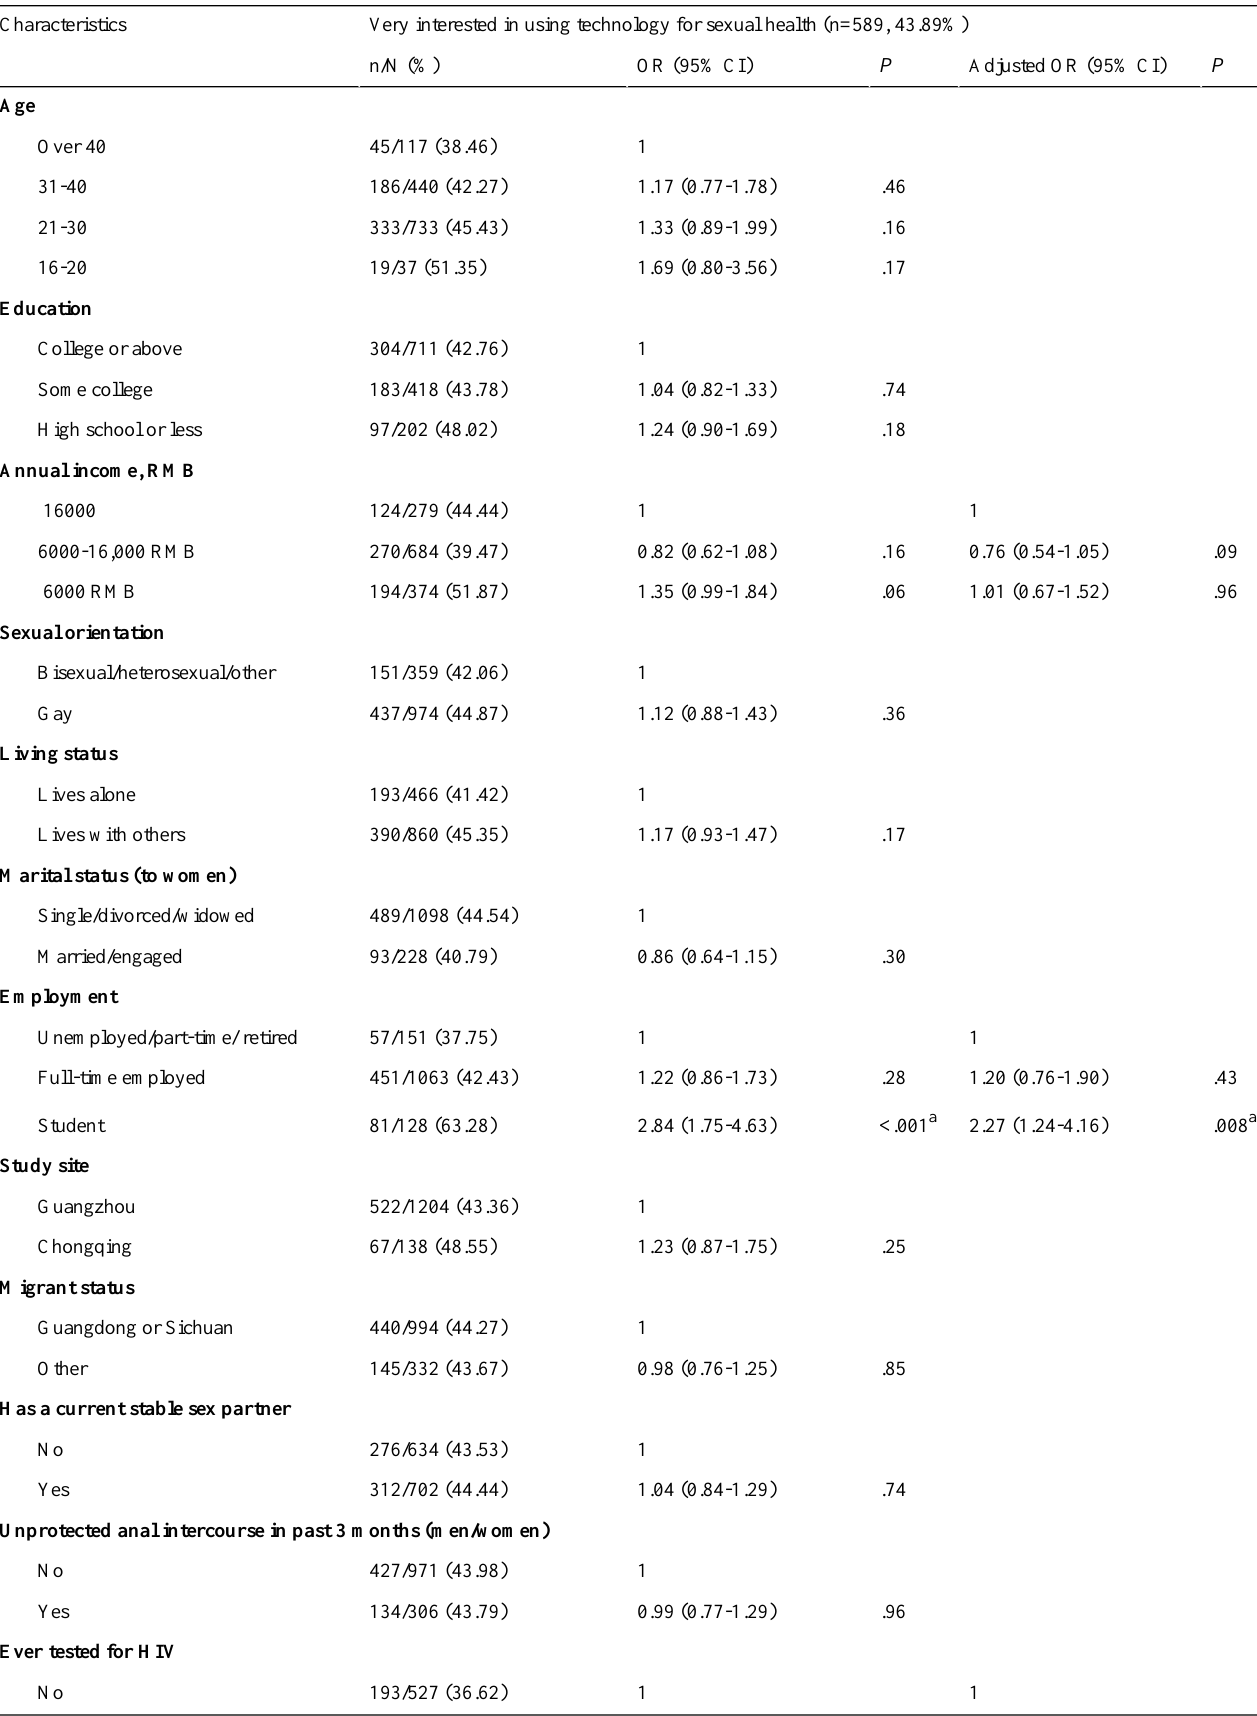
Table 3. Correlates of interest in technology for sexual health among 1342 MSM in China. Very interested in using technology for sexual health (n=589,